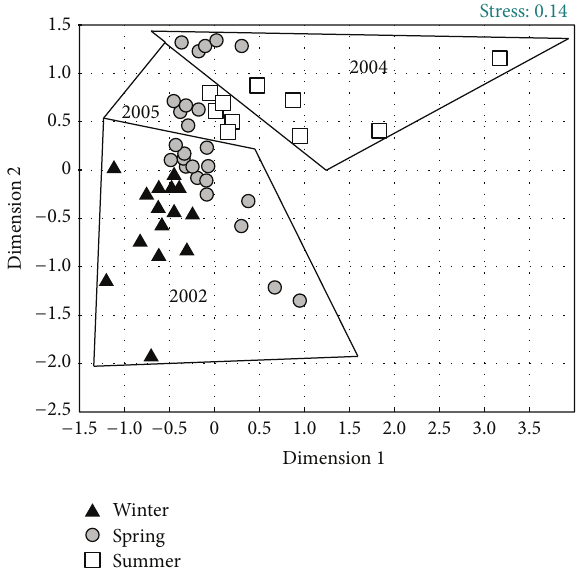
Figure 6: MDS plot showing the ordination of the samples accord- ing to season and